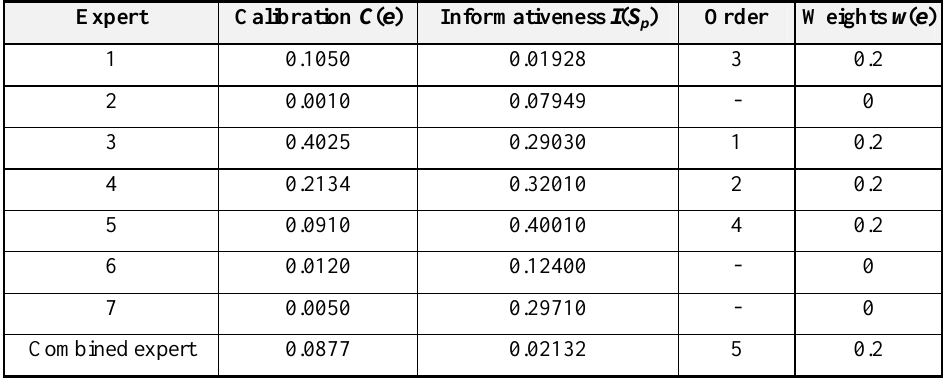
Table 4 – Weights of Experts for Individual